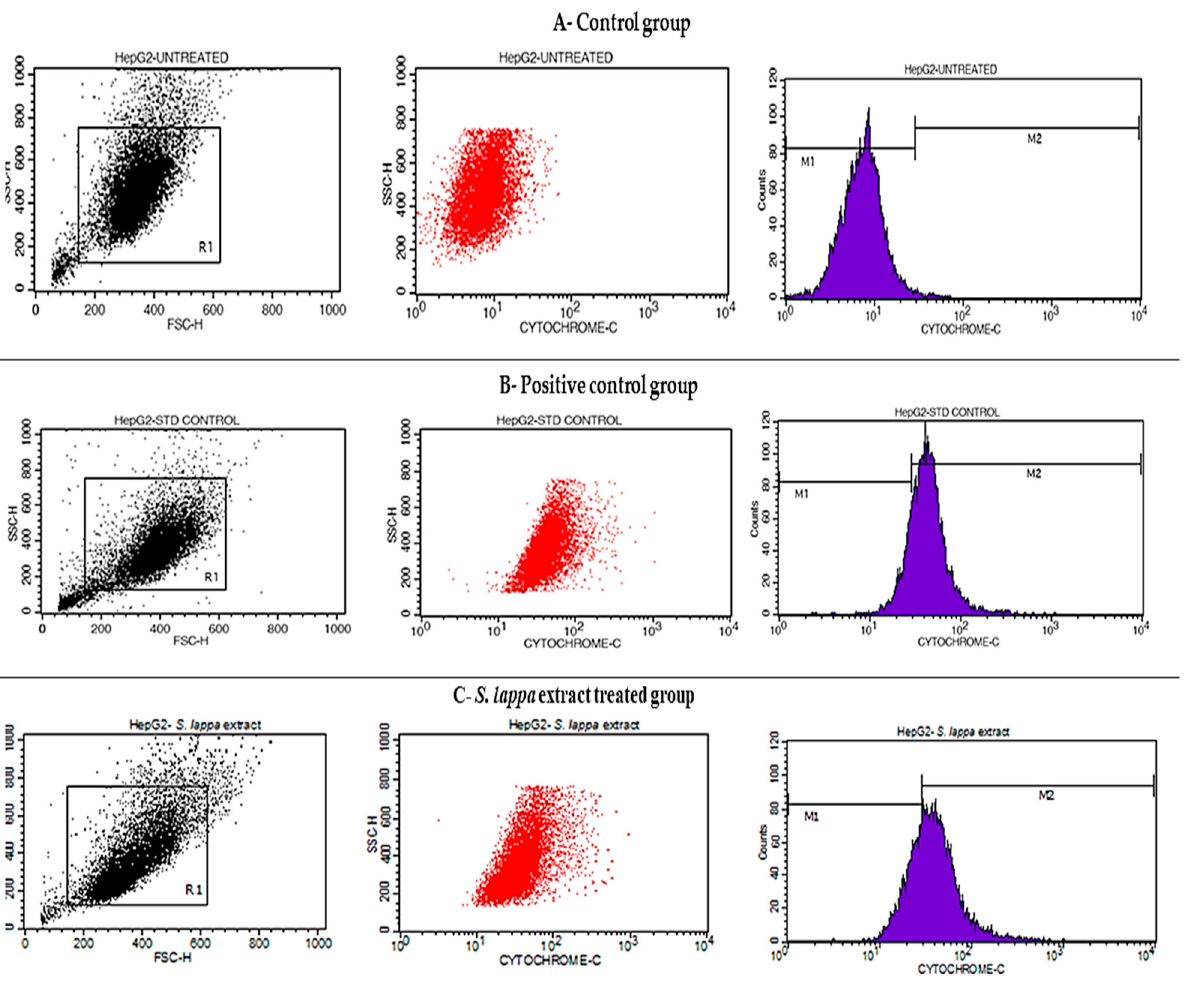
Figure 8. Histograms representing cytochrome C expression study with ( A )—control, ( B )—positive control-treated, and ( C )— S. lappa n-butanol root extract treated with IC50 concentration, viz., 56.76 ug/mL against the HepG-2 cells using BD FACS Calibur, Cell Quest Pro Software (Version: 6.0).